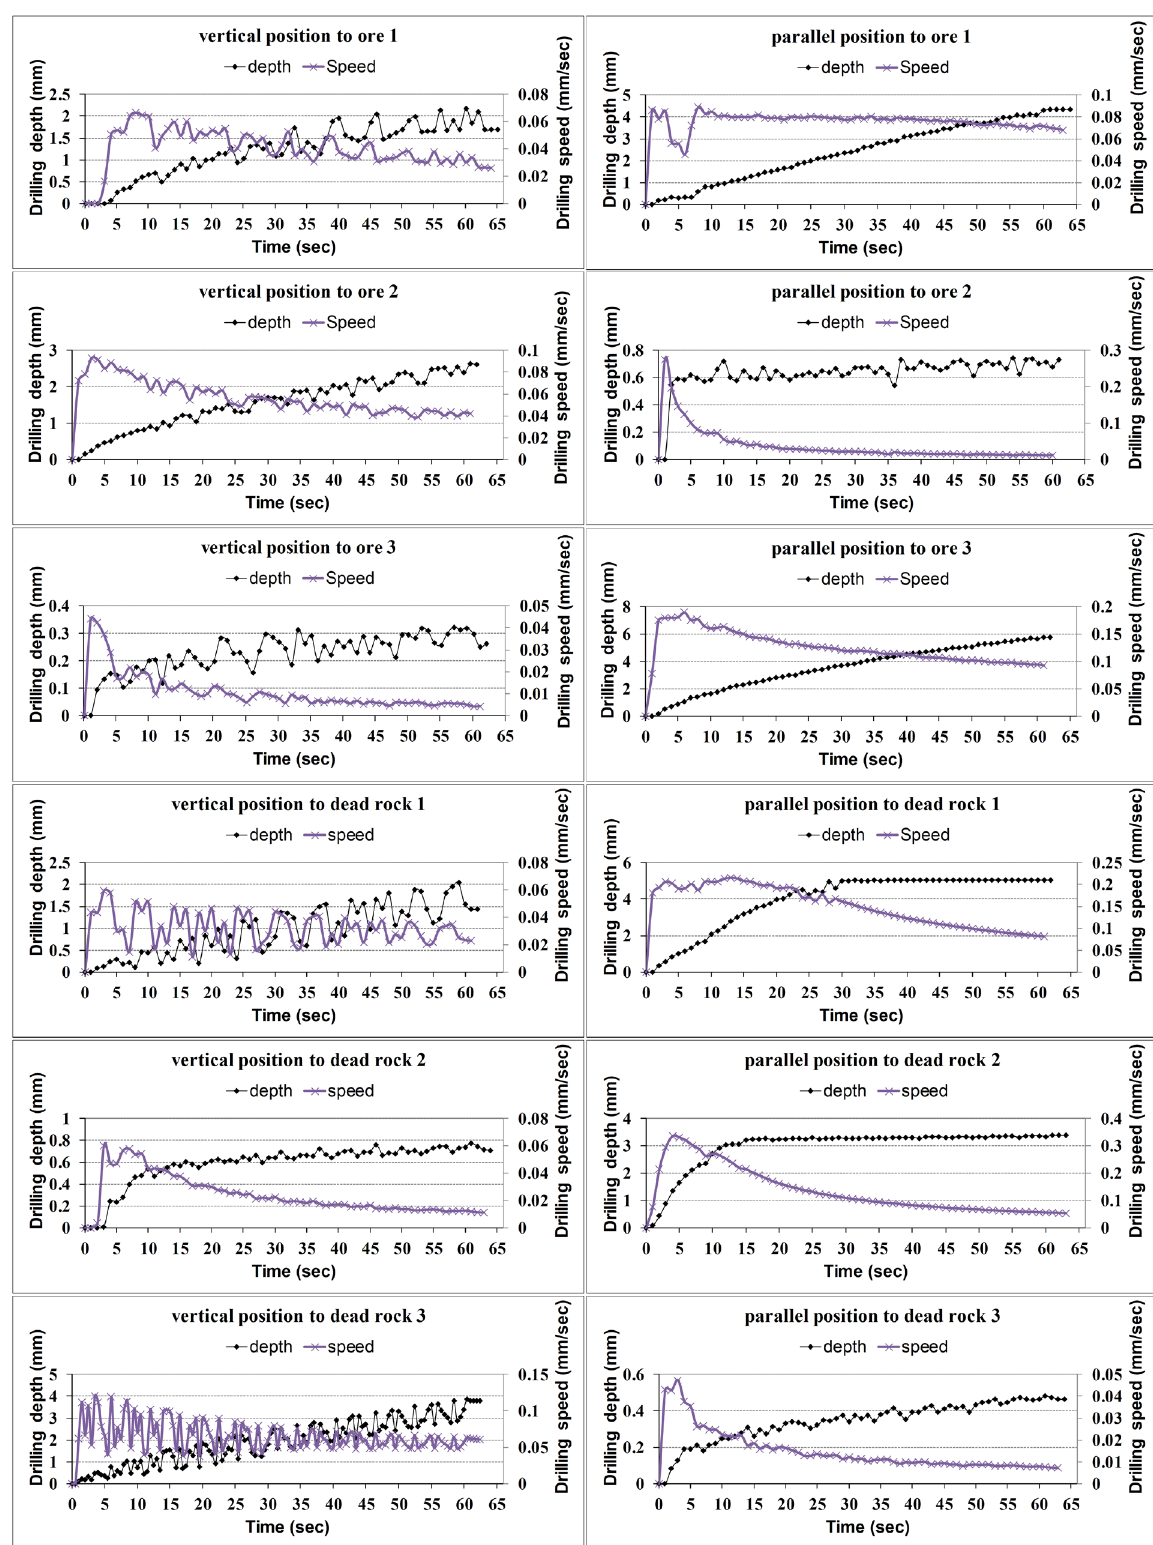
Figure 6. The relationships between drilling speed and drilling depth for different bedding